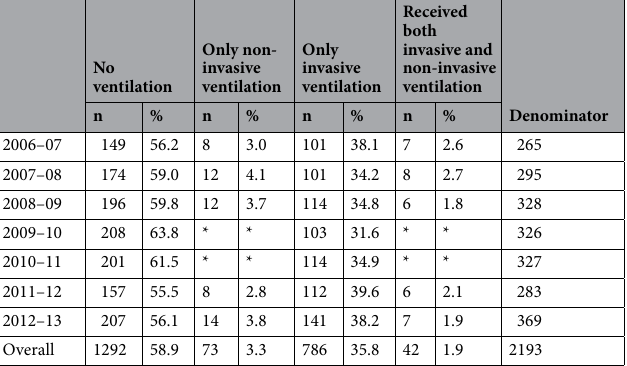
Any form of ventilation support (%, Number of admissions (%) PIM2% (median, IQR) 95% CI) Length of stay (median, IQR) Deaths [n